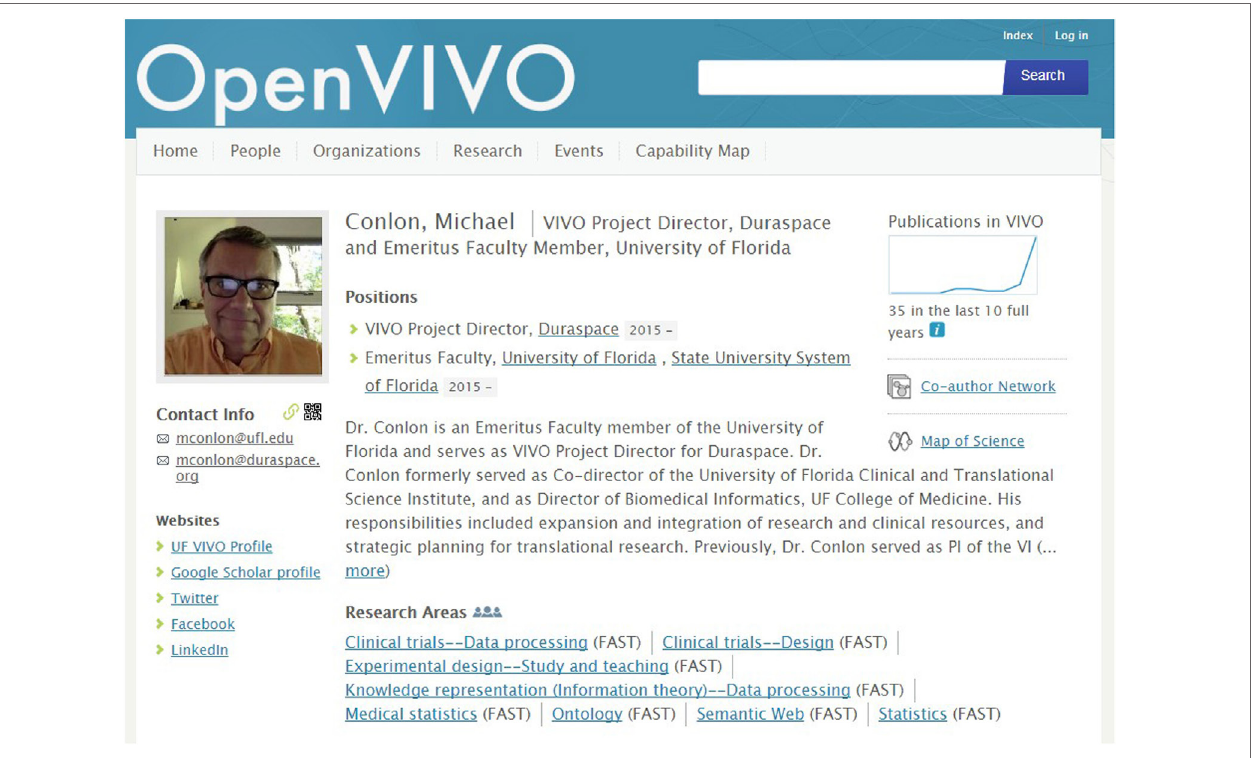
FIguRe 2 | An OpenVIVO profile of Dr. Michael Conlon. Written and informed consent has been obtained from Dr. Michael Conlon for the publication of his identifiable image and his OpenVIVO profile. Users sign on to OpenVIVO using ORCID usernames and passwords. Users edit their overview, title, and contact information. OpenVIVO automatically populates the profile from